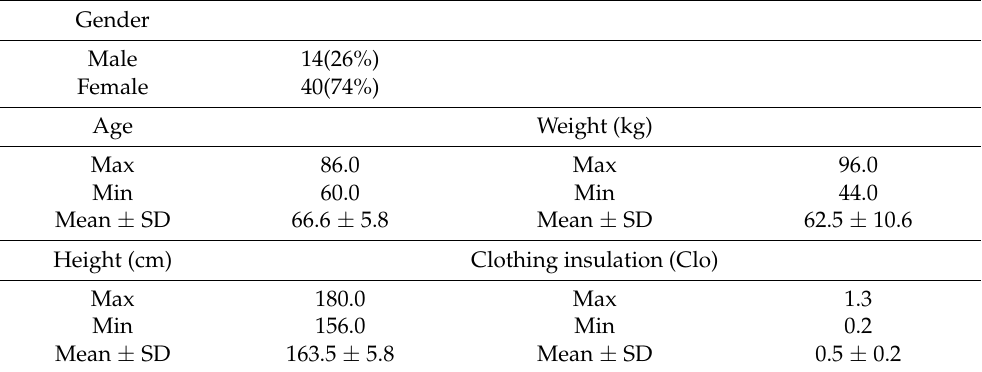
Table 3. Respondents’ attribute.